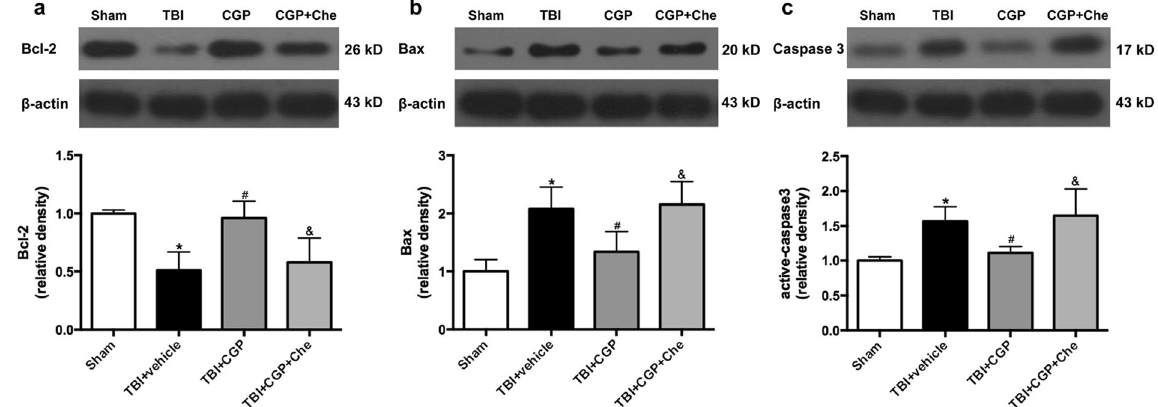
Figure 4. The effects of induced overexpression PCMT1 on the pro-apoptotic proteins expression at 24 h after TBI. Chelerythrine was able to reverse these effects of PCMT1 by activating the cleaved-Mst1 without changing the PCMT1 levels. ( a ) Western blot assay for the expression of Bcl-2. ( b ) Western blot assay for the expression of Bax. ( c ) Western blot assay for the expression of active-caspase3. Data are represented as the mean ± SD, n = 6 rats per group. * P < 0.05 vs sham, # P < 0.05 vs TBI + vehicle, & P < 0.05 vs TBI + CGP. Full-length gels were displayed in supplemental materials.